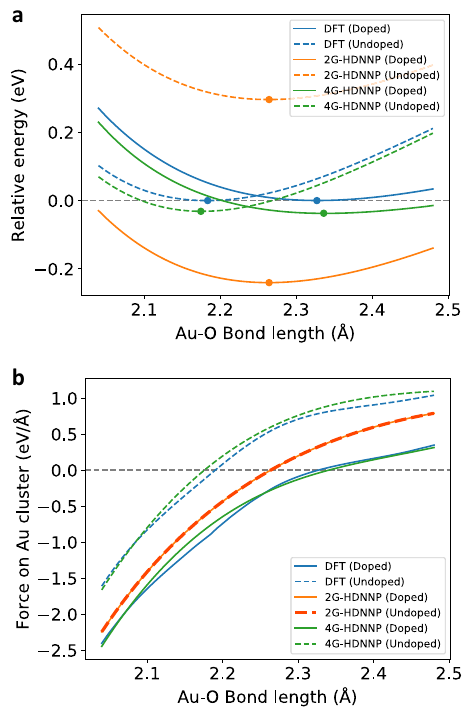
Fig. 9 Energies and forces for the gold cluster. a Relative energy and b sum of forces acting on the Au 2 cluster for the cluster adsorbed at the MgO(001) substrate for the non-wetting geometry for the Al-doped and undoped cases. The local minima of the energy curves are marked with a dot. The Au – O bond-length refers to the distance between the Au closest to the surface and its neighboring oxygen